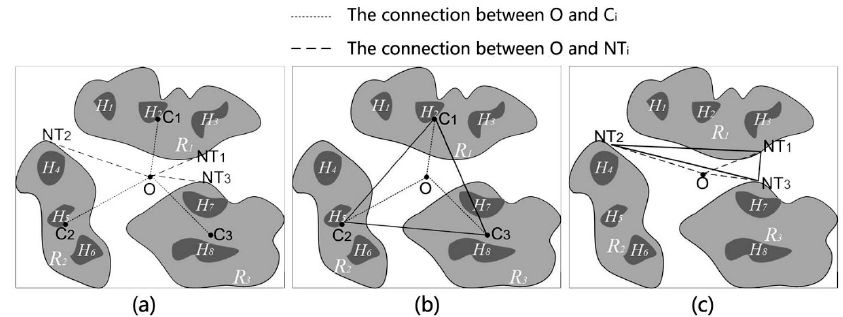
Figure 2. ( a ) Selection of the center point and nearest tangent points; ( b ) center point position graph (CPPG); ( c ) nearest tangent point position (NTPPG).